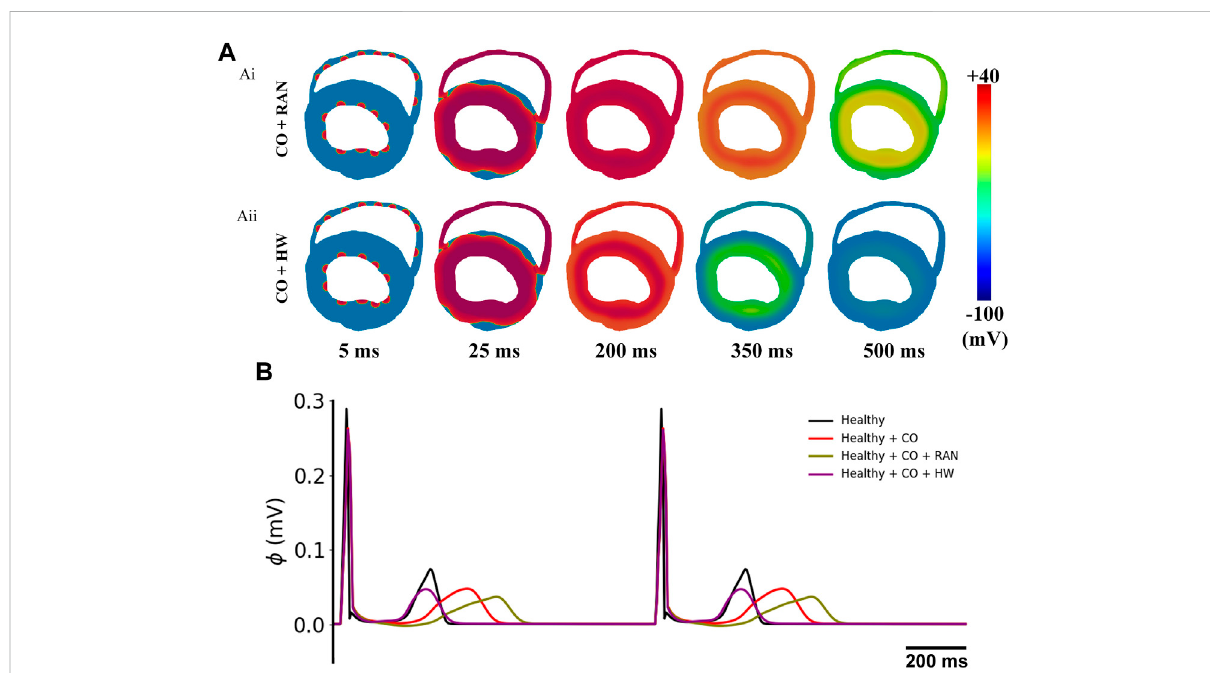
FIGURE 14 Simulation results of the in fl uences of ranolazine and HW-0168 using a 2D realistic ventricular slice. (A) Propagation of excitation waves after applying ranolazine (Ai) or HW-0168 (Aii). (B) Pseudo-ECGs under different